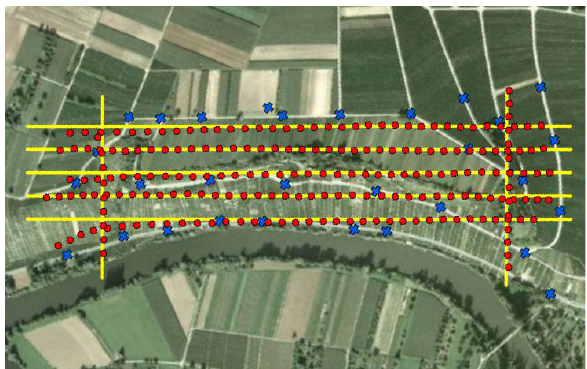
Figure 3: Test-site Vaihingen/Enz, with planned flight lines, camera stations from GPS measurement, and signalized points.